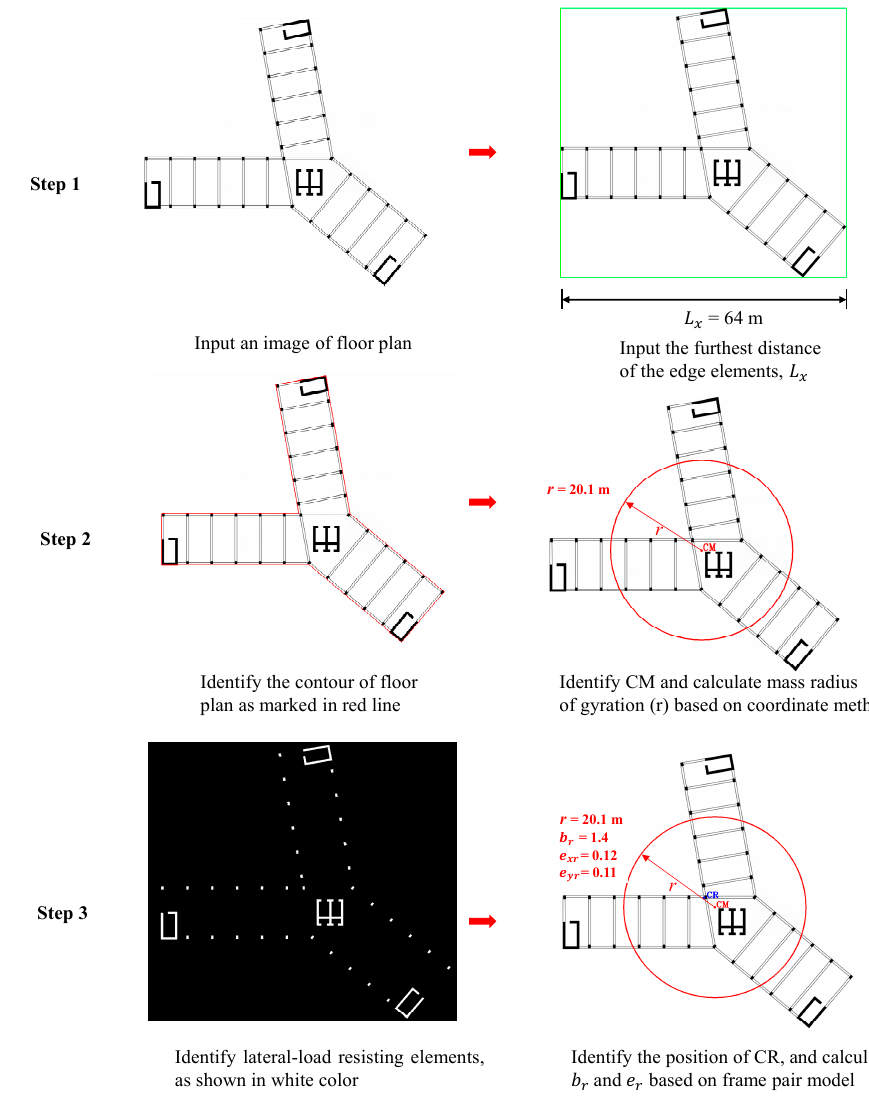
Figure 1. Schematic view of torsional stability assessment using the image scanning tool.